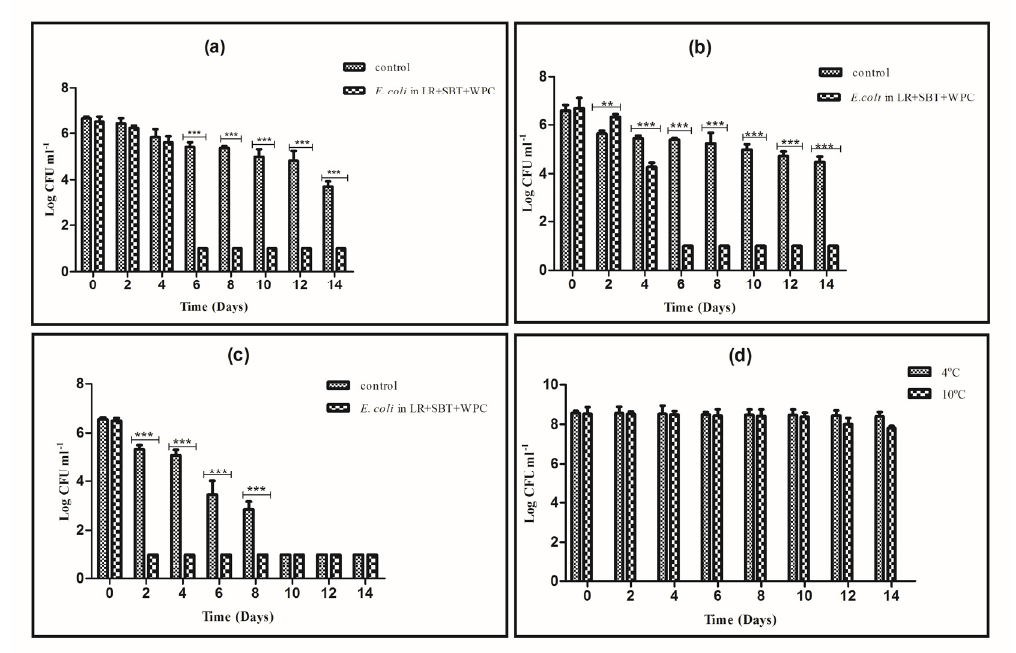
Figure 3. Anti ‐ E. coli activity of L. rhamnosus GG fortified ‐ WPC ‐ supplemented sea buckthorn juice (LR + SBT + WPC) at ( a ) 4 °C, ( b ) 10 °C, ( c ) 37 °C, ( d ) viability of L. rhamnosus GG at 4 °C and 10 °C